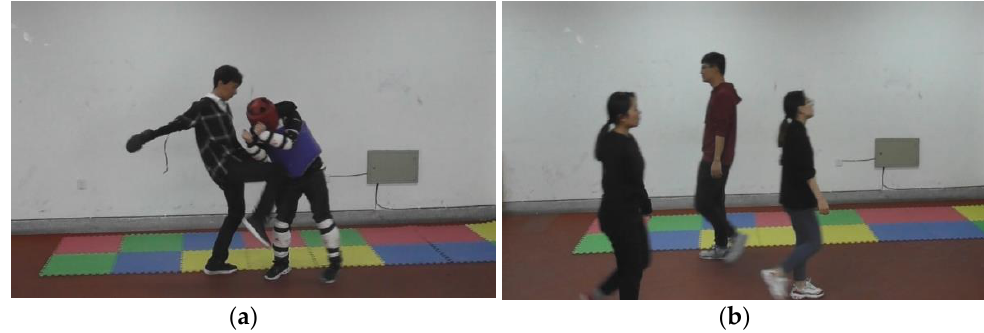
Figure 1. Two examples of the collected video frames: ( a ) a violent scene; ( b ) a non-violent scene.